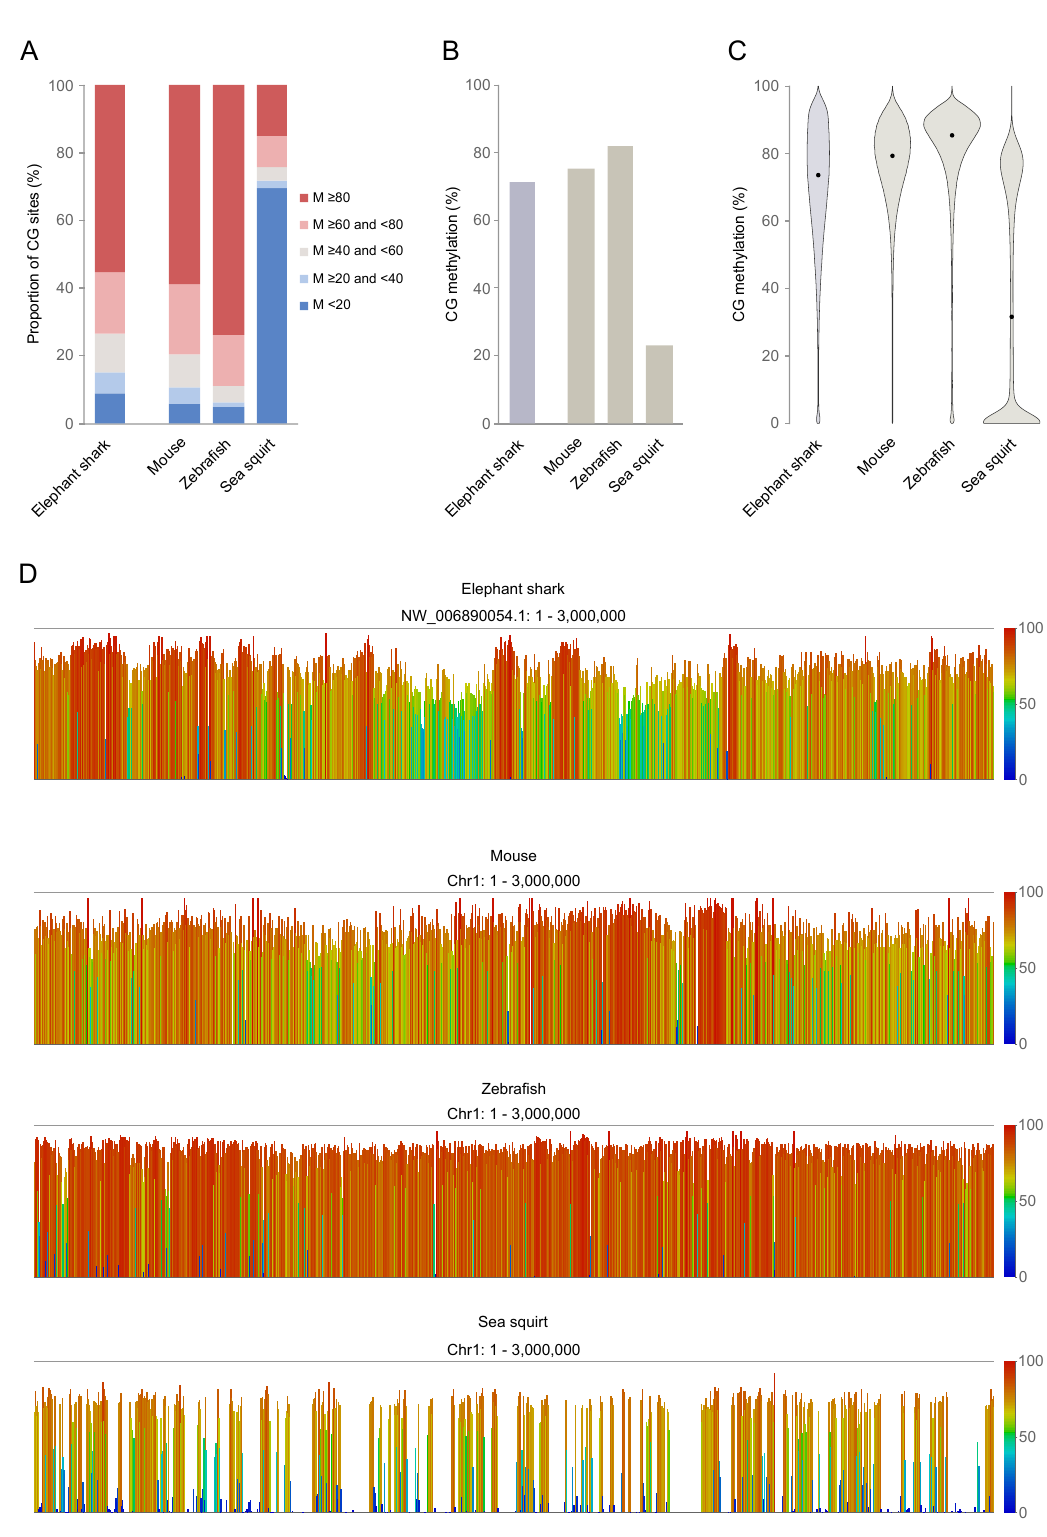
Figure 3. Global structure of the elephant shark methylome. A: Distribution of methylation at individual CG dinucleotides. ‘M’ denotes percentage CG methylation. B: Mean methylation of CG dinucleotides. C: Distribution of methylation within 2kb running windows covering the entire genome. Black dots denote the median. D: Genome screenshots of methylation quantified in 2kb running windows over the first 3Mb of chromosome 1 in sea squirt, zebrafish and mouse, and of the largest scaffold (NW_006890054.1) in elephant shark. These regions were arbitrarily chosen as an unbiased section of each